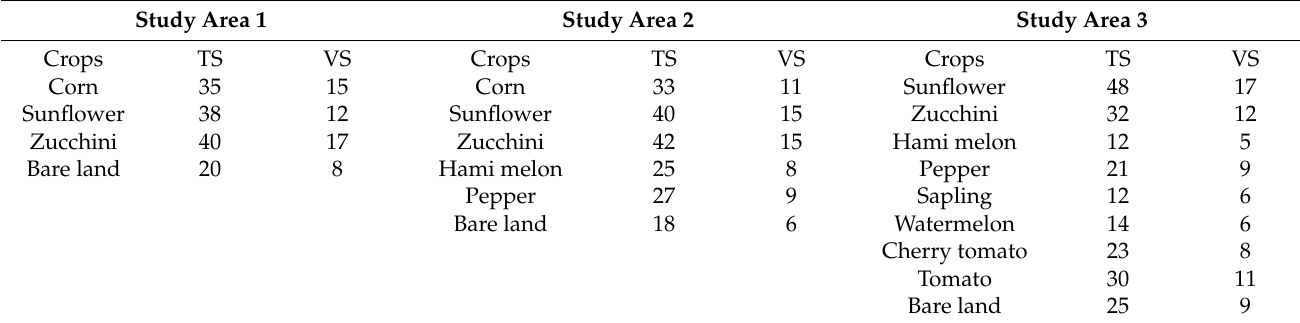
Table 4. Number of training and validation samples for each study area.